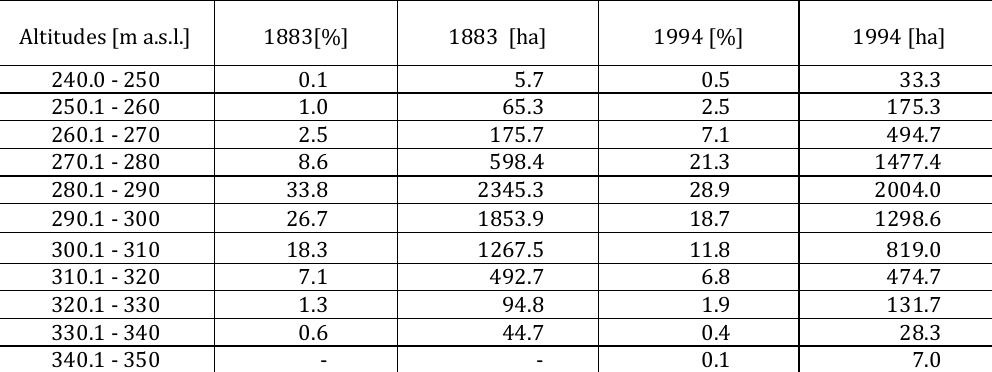
Table 3. Surface percentage of the Bytom area in the determined height ranges (the author’s own work) Altitudes [m a.s.l.] 1883[%] 1883 [ha] 1994